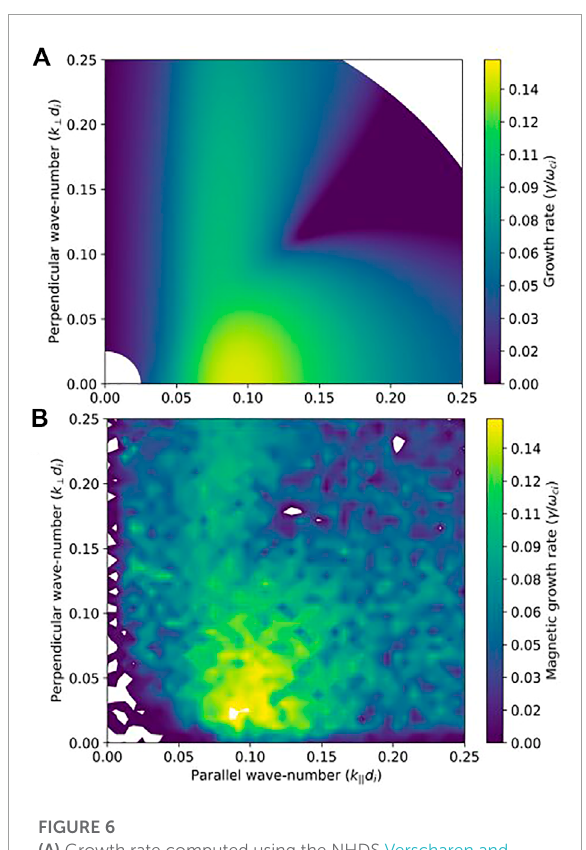
FIGURE 6 (A) Growth rate computed using the NHDS Verscharen and Chandran, (2018) as a function of parallel ( k ‖ d i ) and perpendicular ( k ⊥ d i ) normalized wave numbers for a beam of density n b / n 0 = . 02, Alfven Mach number M A = 10, and beam thermal speed of v thb = 3 v A . (B) Growth rate extracted from a 2D hybrid simulation with the same parameters as above measured by taking a time derivative of the magnetic field fluctuations.